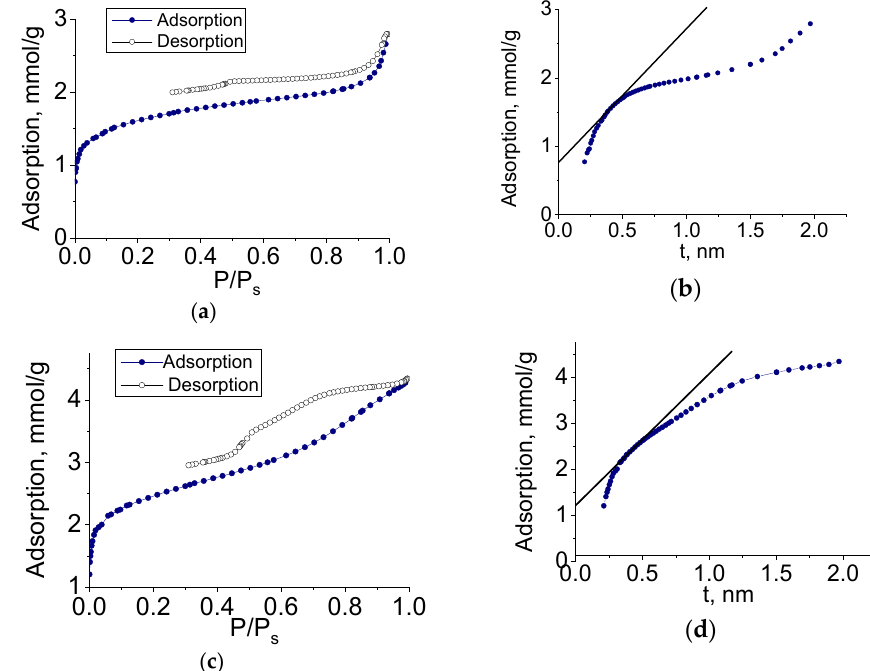
Figure 8. ( a , b ) Nitrogen adsorption isotherms and ( c , d ) t-plots of Mo 2 C synthesized from molyb-